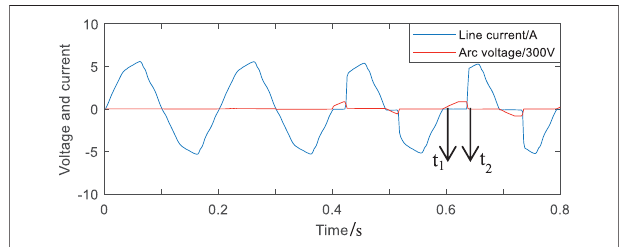
FIGURE 2 | Voltage and line current waveforms at both ends of the AC arc.